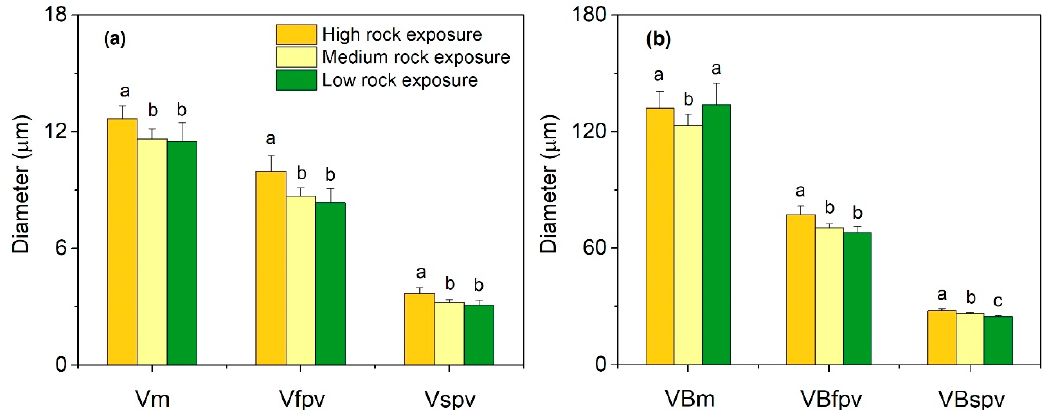
Figure 4. Vascular anatomical traits of Phyllostachys glauca from three habitats (high rock exposure, medium rock exposure, and low rock exposure) in the limestone mountain. ( a ), the vessel diameters of different veins; ( b ), the vascular bundle diameters of different veins. Vm, vessels of midrib; Vfpv, vessels of first-order parallel vein; Vspv, vessels of second-order parallel vein; VBm, vascular bundles of midrib; VBfpv, vascular bundles of first-order parallel vein; and VBspv, vascular bundles of second-order parallel vein. Values are means ± S.E. ( n = 100). Lowercase letters that differ within an anatomical trait indicate significant ( p < 0.05) differences among different habitats.